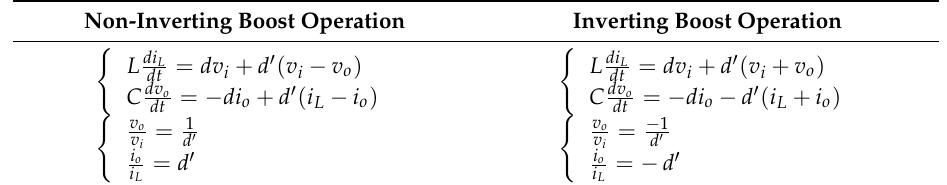
Table 2. PWM switching average modelling and corresponding transfer ratio for boost operation.